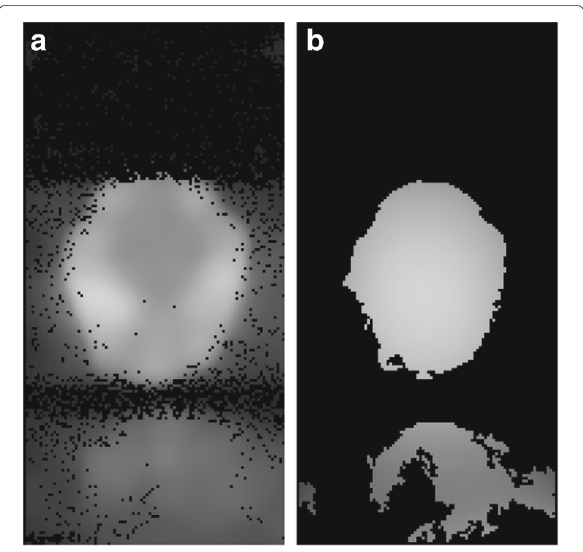
Fig. 2 Bias field estimation by a Li’s method [22]; b the proposed method in this